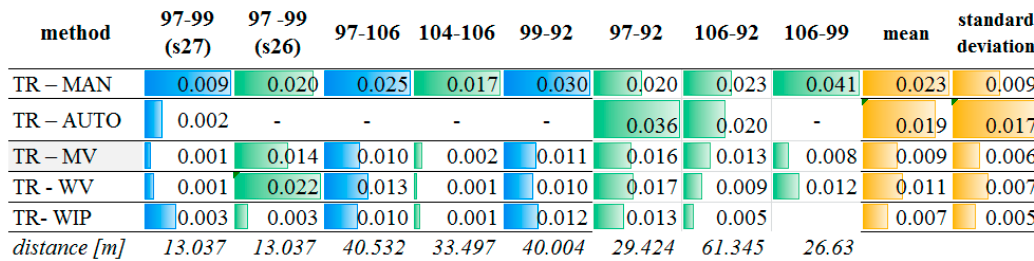
(Figure 14). Methods of target centre determination are color-coded: black—automatic, yellow—manual, red—mean value/mass (variant I), orange—weighted mean value (variant II), green—weighted inter extreme points ( WIP